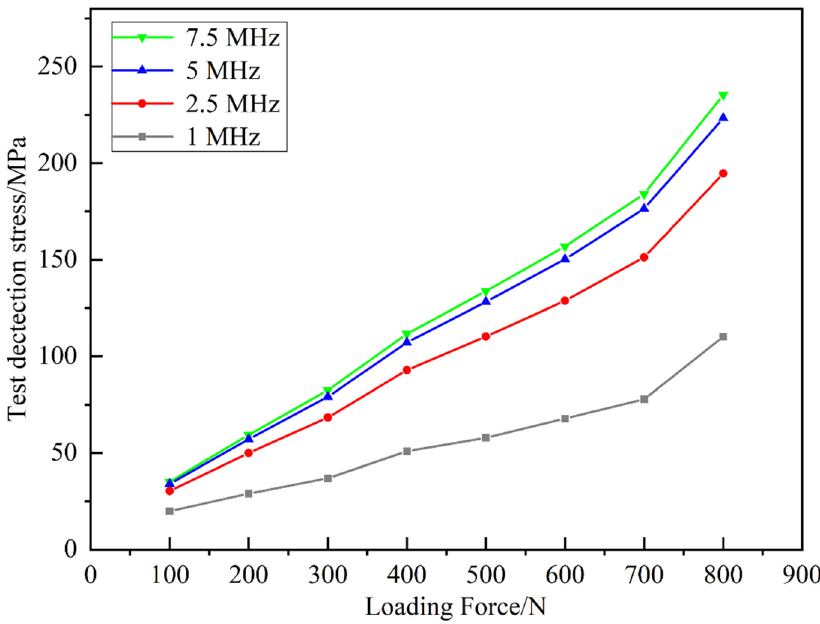
Figure 12. Test results of multi-frequency L CR wave cantilever beam stress loading.